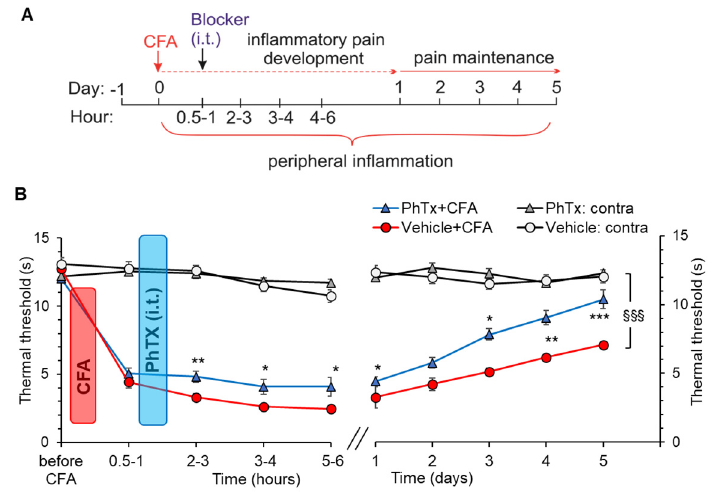
Figure 8. Selective inhibition of Ca 2+ -permeable AMPARs in the spinal cord alleviates inflammatory pain of thermal modality in rats with peripheral inflammation. ( A ) An experimental scheme of post-treatment with philantotoxin − 74 (PhTx, 1 µ M), given intrathecally (i.t.) after the development of peripheral hypersensitivity in rats induced by the intraplantar injection of CFA. ( B ) The time course of changes in the paw withdrawal latency in response to heat stimulus (thermal nociceptive threshold) before and following i.t. administration of the blocker in the experimental groups of animals with ipsilateral CFA-induced peripheral inflammation. The time points tested and the scheme of treatment are as shown on A. * p < 0.05, ** p < 0.01, *** p < 0.001 versus the corresponding time in the CFA ‐ inflamed group without PhTx; §§§ p < 0.001 versus to the corresponding time on the contralateral (non ‐ inflamed) side.